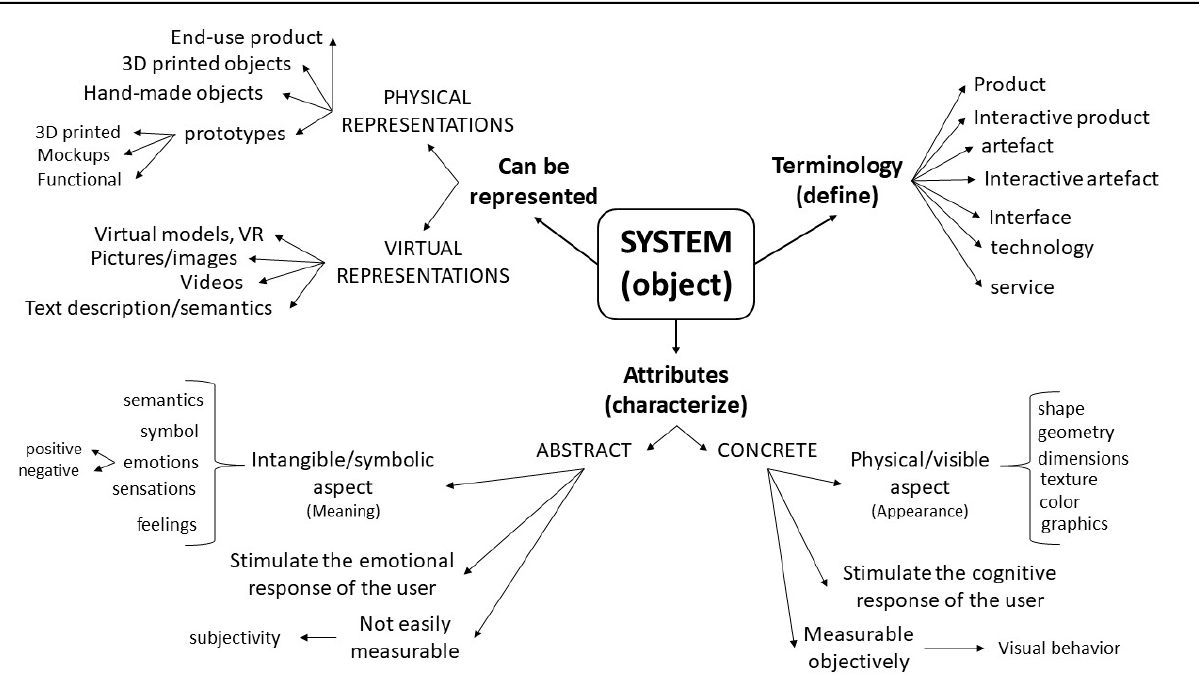
Figure 4. Graphic representation of the elements that define, characterize, and form representations of the system based on literature contributions.